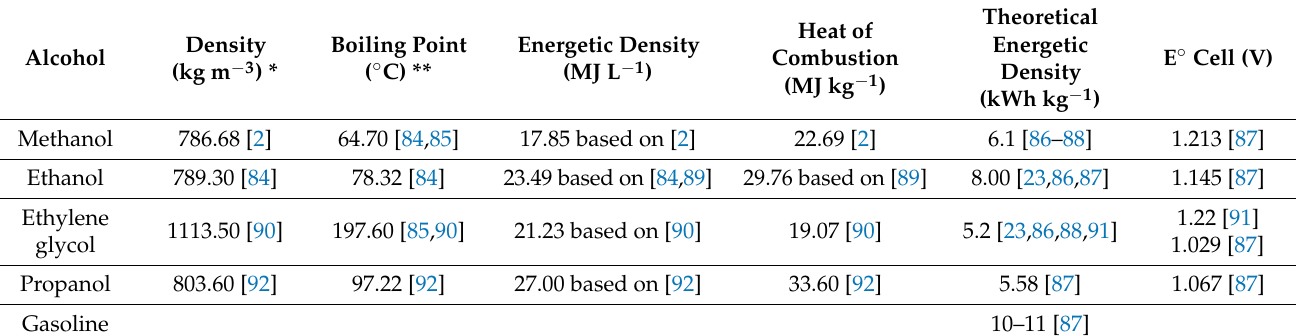
Table 1. Physical properties of mentioned